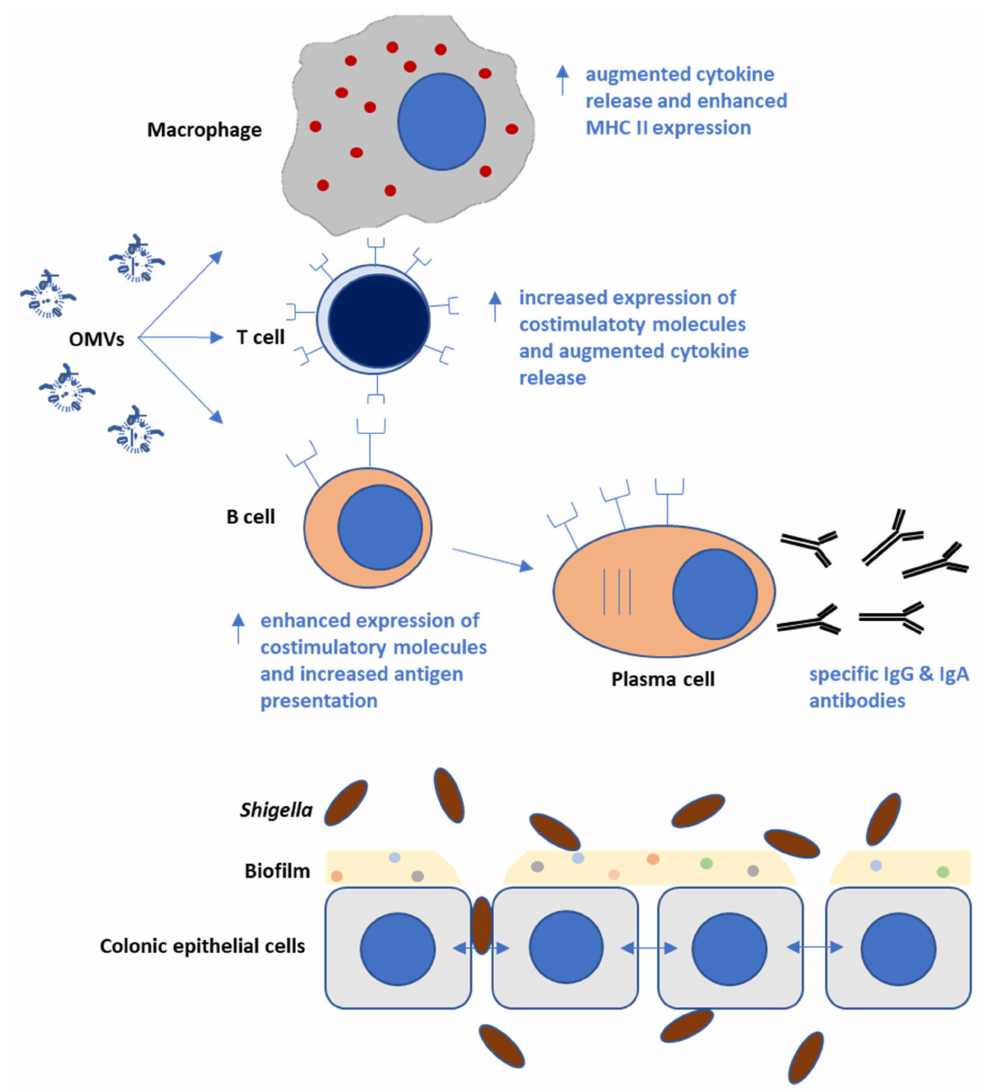
Figure 2. Shigella OMVs induce the release of different cytokines, chemokines, and specific antibodies by different immune cells, including macrophages, B and T lymphocytes. Their immune-stimulatory properties make OMVs attractive targets for vaccination against